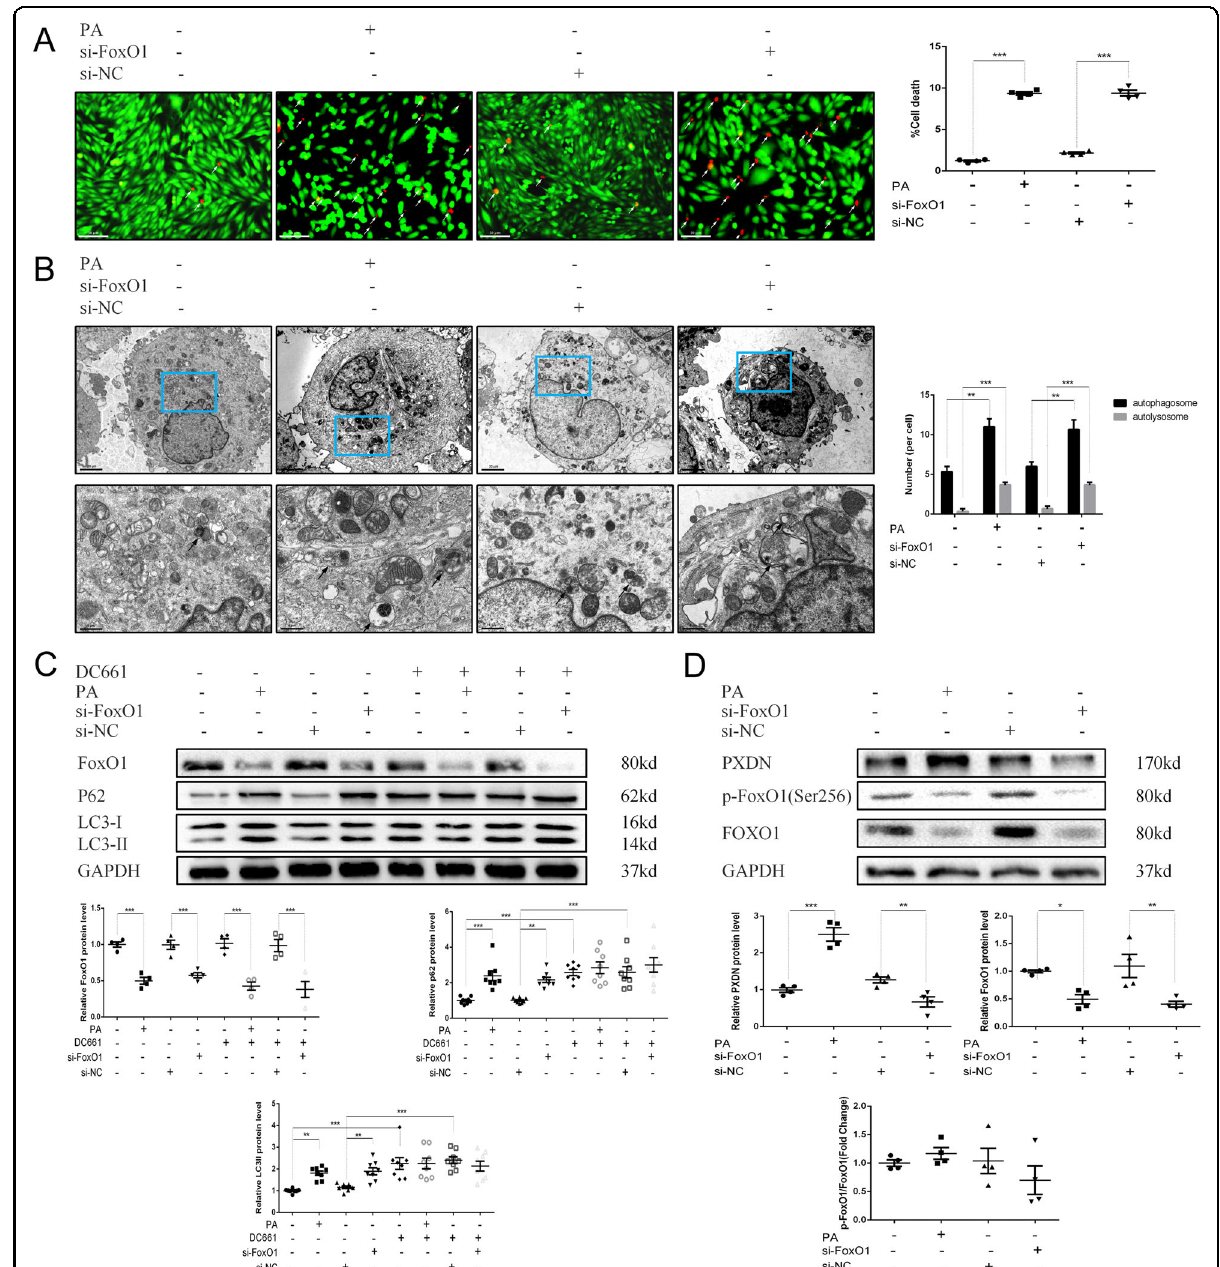
Fig. 5 The effect of FoxO1 on PXDN. A H9C2 cells were treated with 50 μ M si-negative control (NC), 50 μ M si-FoxO1, 400 μ M palmitate acid (PA), or 400 μ M bovine serum albumin (BSA) for 24 h. Cell survival was evaluated using fl uorescence staining with calcein acetoxymethyl ester (Calcein-AM) for live cells in green and ethidium homodimer-1 (EthD-1) for dead cells in red. The percentage of cell death was shown on the right side (scale bar = 50 μ M, n = 4). B Autophagosomes and autolysosomes in PA-treated H9C2 with 50 μ M NC, 50 μ M si-FoxO1, 400 μ M PA, or 400 μ M BSA were detected by transmission electron microscopy. Black Arrow referred to autophagosomes and white arrow referred to autolysosomes. The number of autophagosomes and autolysosomes per cell was shown on the right side (scale bar = 20 μ m in top and 6 μ m in bottom, respectively. n = 3). C H9C2 cells were treated with 50 μ M si-NC, 50 μ M si-FoxO1, 400 μ M PA, or 400 μ M BSA for 24 h (with or without 1 μ M DC661). FoxO1, LC3II, and p62 levels were detected by western blot and quantitative analyses were shown below ( n = 4 – 8). D H9C2 cells were treated with 50 μ M NC, 50 μ M si-FoxO1, 400 μ M PA, or 400 μ M BSA for 24 h. PXDN, p-FoxO1, and FoxO1 levels were detected by western blot and quantitative analyses were shown below ( n = 4 – 8). Data were presented as mean ± SEM. One-way ANOVA test was used. * P < 0.05, ** P < 0.01, *** P <